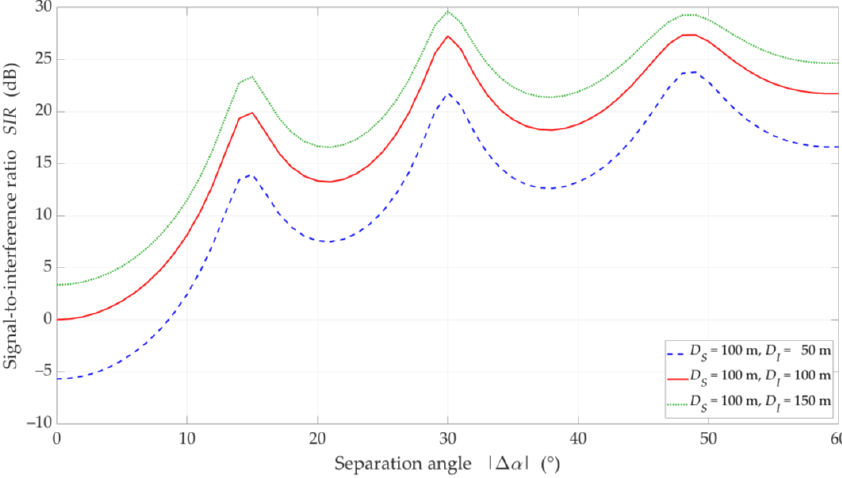
Figure 10. SIR versus separation angle for UL scenario, selected D I = {50, 100, 150} m, D S = 100 m, and LOS (TDL-D) conditions.